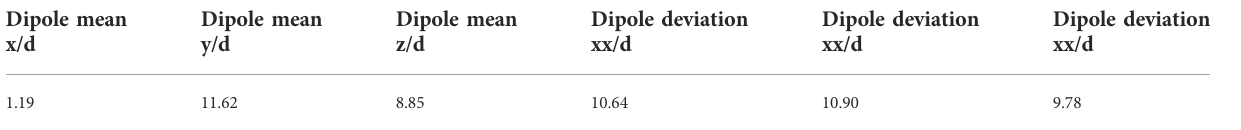
TABLE 4 PI permittivity correlation data.